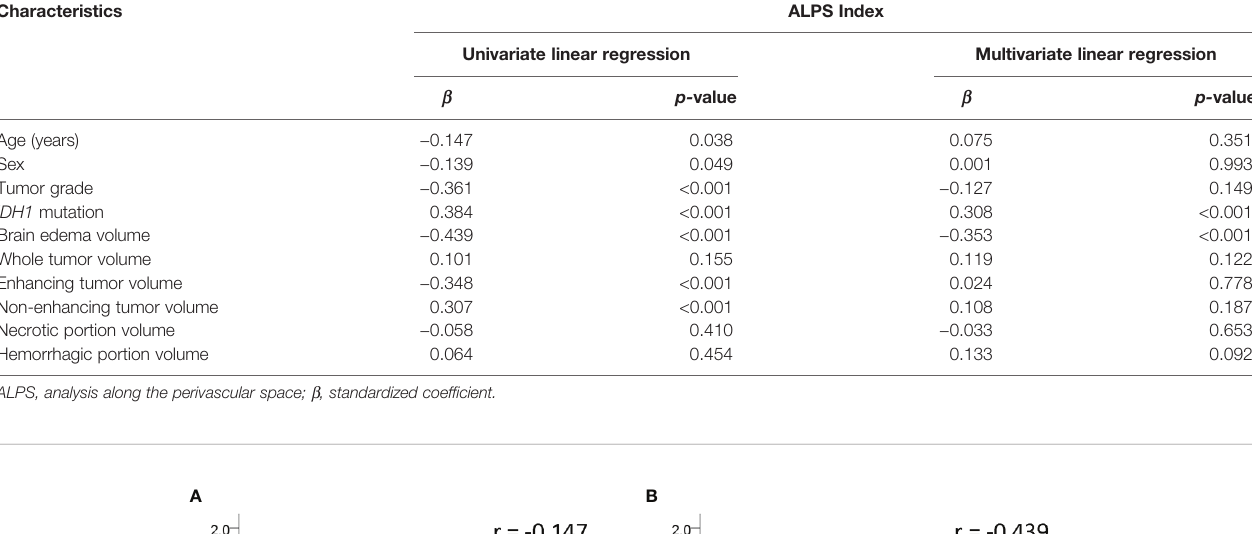
TABLE 3 | Univariable and multivariable linear regression analyses of factors associated with the ALPS index. Characteristics